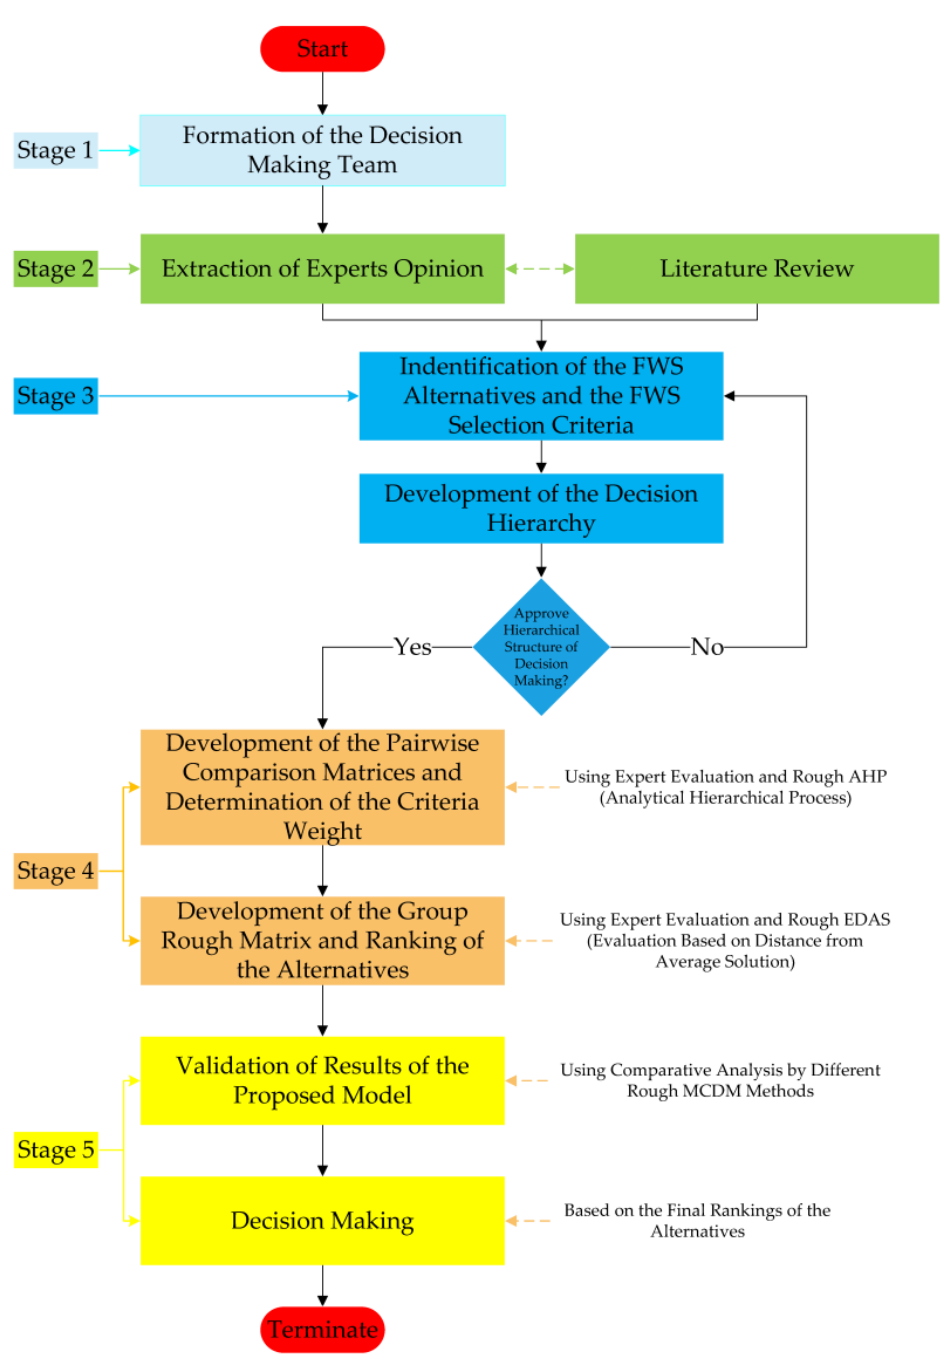
Figure 1. Research methodology flowchart of the proposed approach.